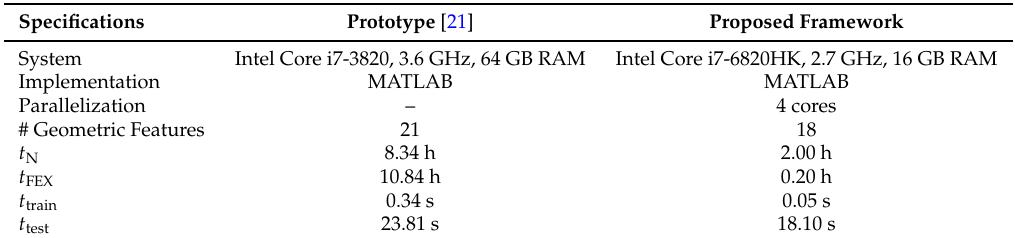
Table 3. Specifications for our prototype framework presented in [21] and for our proposed